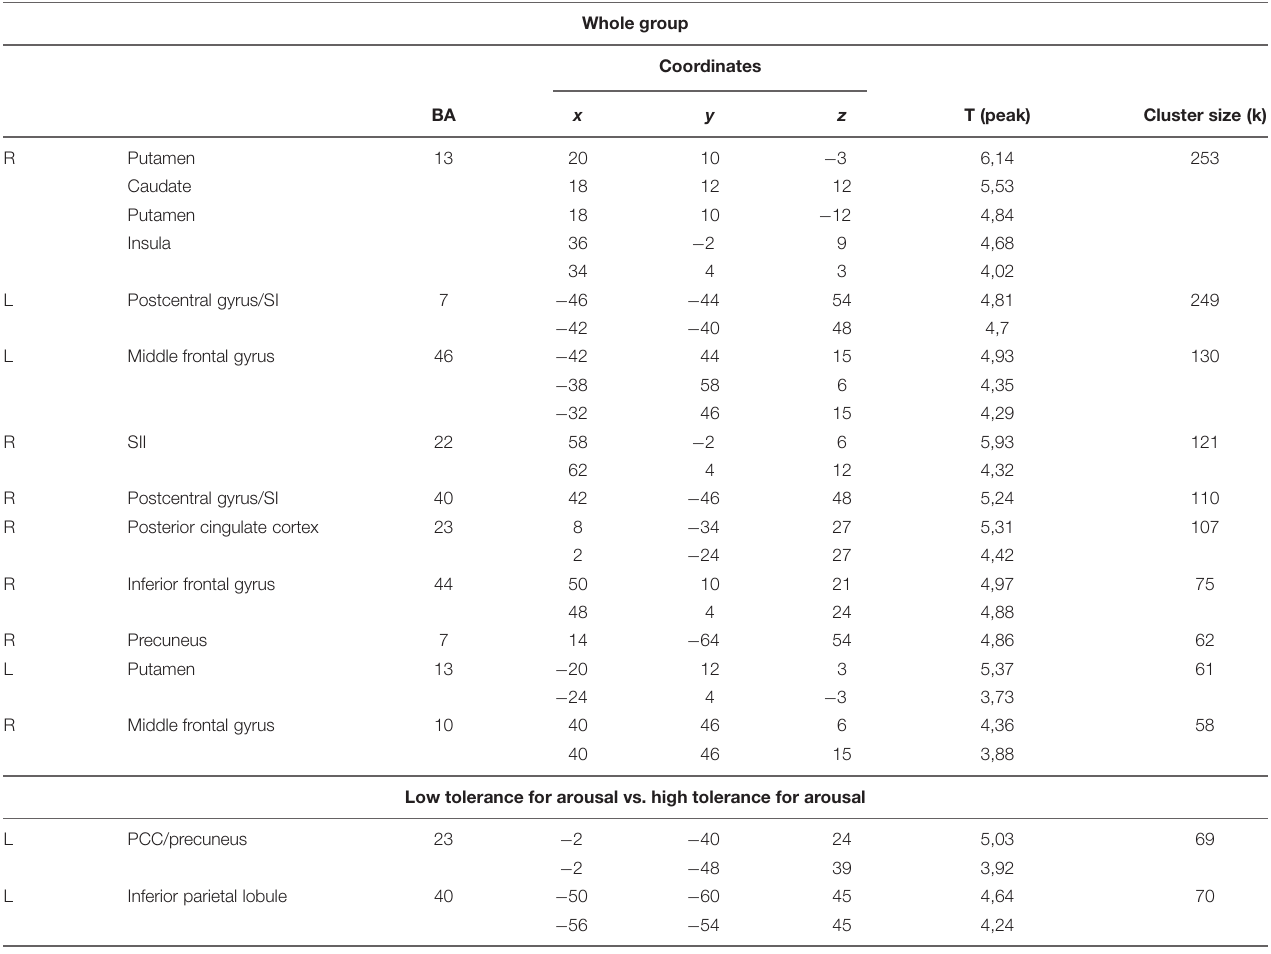
TABLE 1 | Areas significantly more activated after frustration induction during Braille characters discrimination task (Braille II vs. Braille I) for the whole group and for the low and high tolerance for arousal groups.